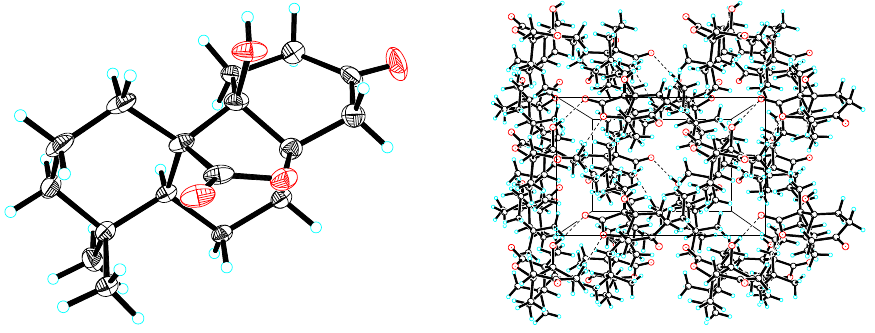
Figure 5. X-ray crystallographic structure of 2 .